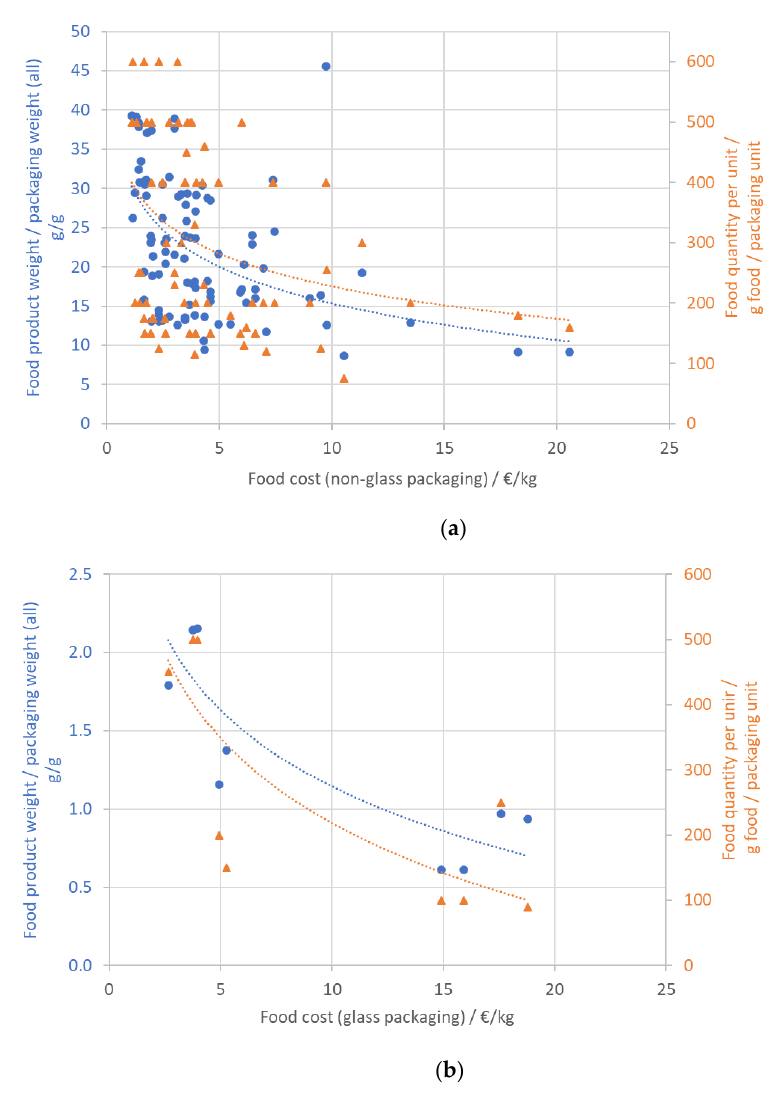
Figure 17. Packaging use related to food costs; ( a ): non-glass packaging, ( b ): glass packaging .